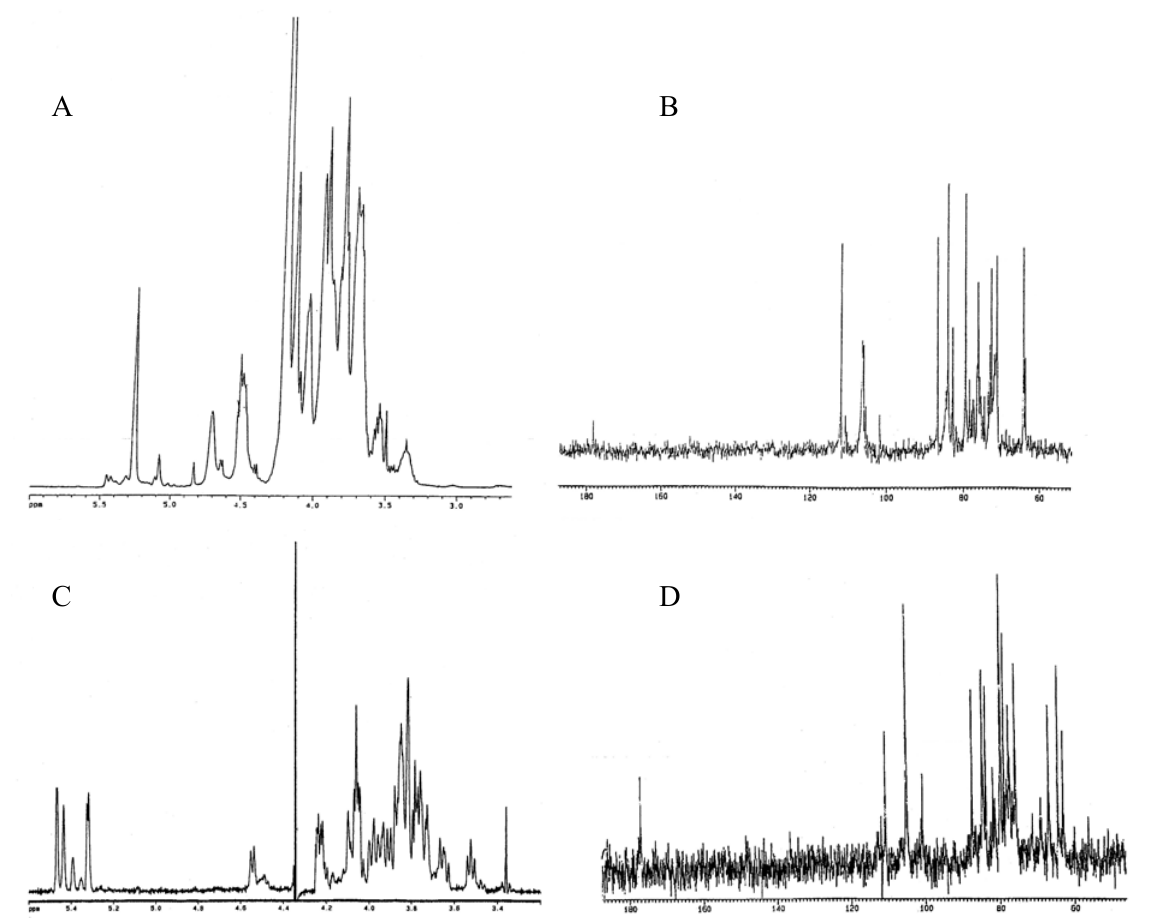
Figure 2 . 1 H-NMR spectra of EPS(2) and EPS(3), panels A and C, respectively. 13 C- NMR spectra of EPS(2) and EPS(3), panels B and D,